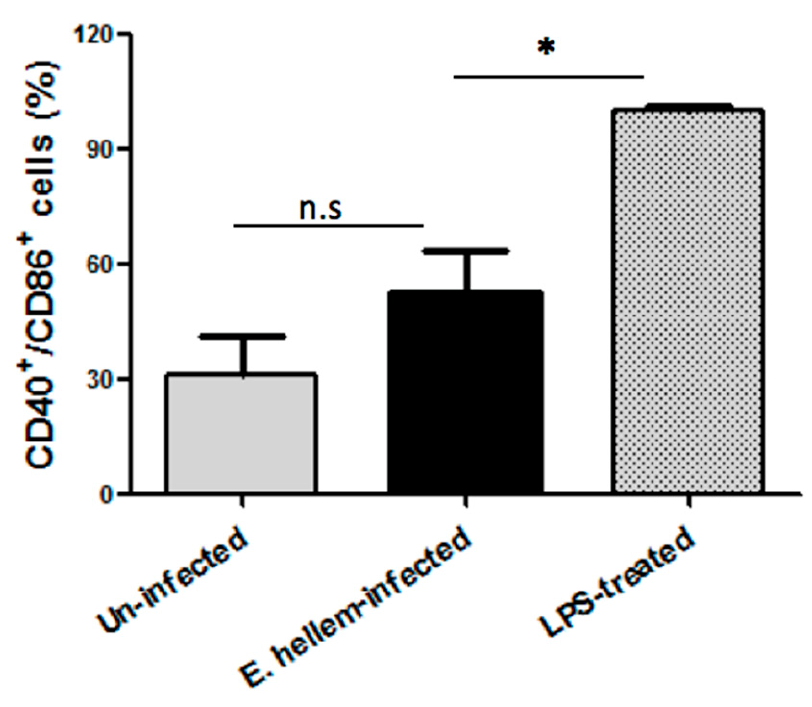
Figure 5. Flow cytometry analysis of DCs maturation. DCs isolated from uninfected control mice, E. hellem -infected mice and LPS-treated mice were subjected to flow cytometry analysis. The amounts